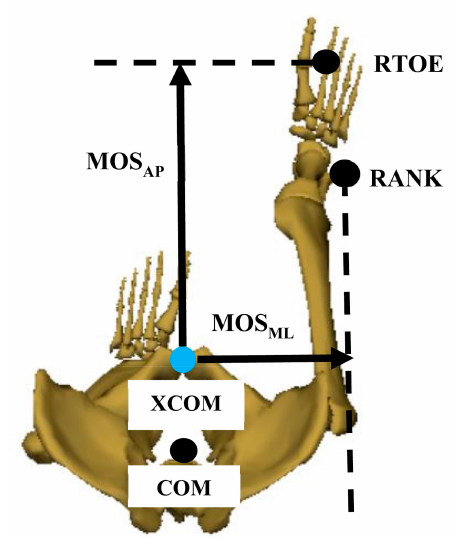
Figure 2. Illustration of the calculation of margin of stability